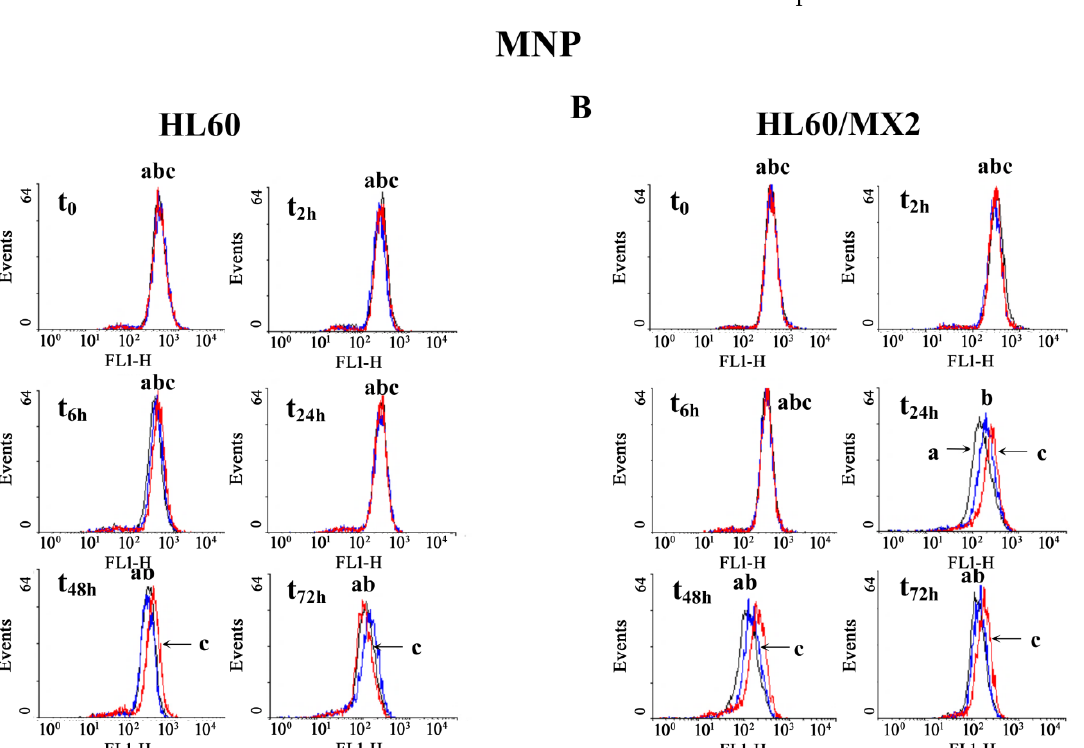
Figure 10. The effect of MNP on lysosomal integrity in sensitive HL60 ( A , C ) and resistant HL60/MX2 ( B , D ) leukaemia cells. The cells were incubated at 37 °C with MNP used at IC 20 (7.5 µM for HL60 cells and 7.2 µM for HL60/MX2 cells) or at IC 50 (24.3 µM for HL60 cells and 20.5 µM for HL60/MX2 cells), respectively, up to 72 h. The lysosomal integrity of the cells was examined with the use of flow cytometry by measuring the level of LysoTracker Green DND-26, a specific fluorescent lysoso- mal probe. The green fluorescence (FL-1 channel) of 5 × 10 3 events per sample was measured with the use of a laser beam at 530 ± 15 nm (λ ex = 488 nm). Presented histograms ( A , B ) are representative examples observed for control and treated cell samples (a, black — control cells; b, blue — cells treated with MNP at IC 20 ; and c, red — cells treated with MNP at IC 50 ). The experiment was repeated at least four times (made in triplicate) and the data are given as the mean ± SD values ( C , D ). Statistical analysis of the differences between values found for cells treated with MNP at IC 20 or IC 50 was carried out using Student’s t -test (no statistically significant changes were found, p > 0.05).